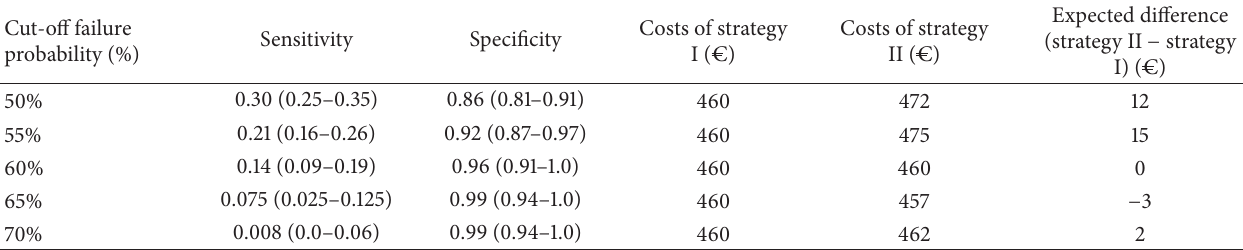
Table 2: Accuracy, uncertainty, and impact of cut-off values for predicted probability of a failed endometrial biopsy in women with postmenopausal bleeding and endometrial thickness of > 4.0 mm.